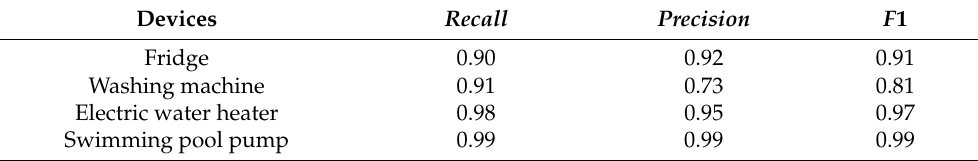
Table 10. KNN results.